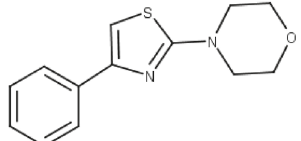
FIGURE 25 - Structure of the compound 4-(4-phenylthiazol-2- yl)-morpholine